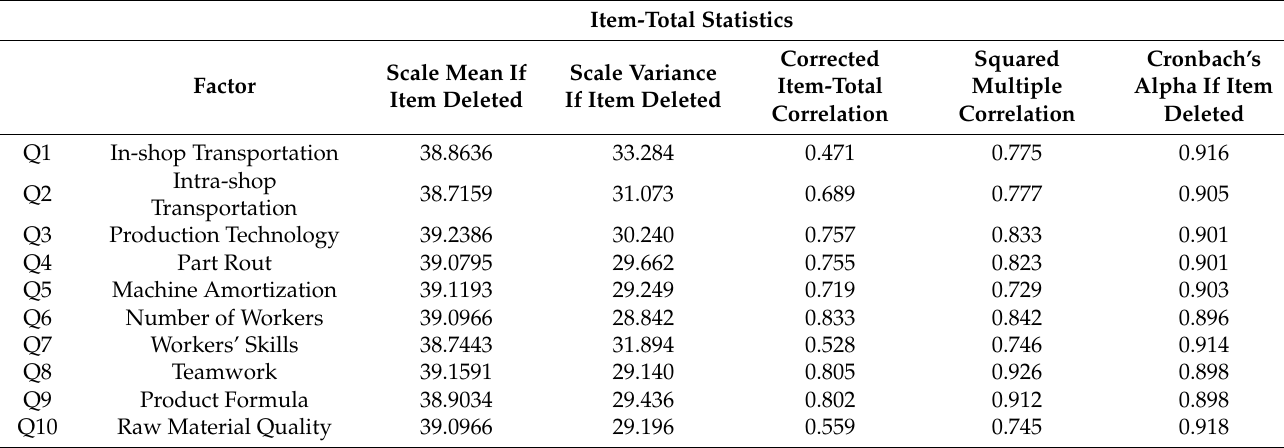
Table 1. Cronbach’s alpha values for the reliability of the designed